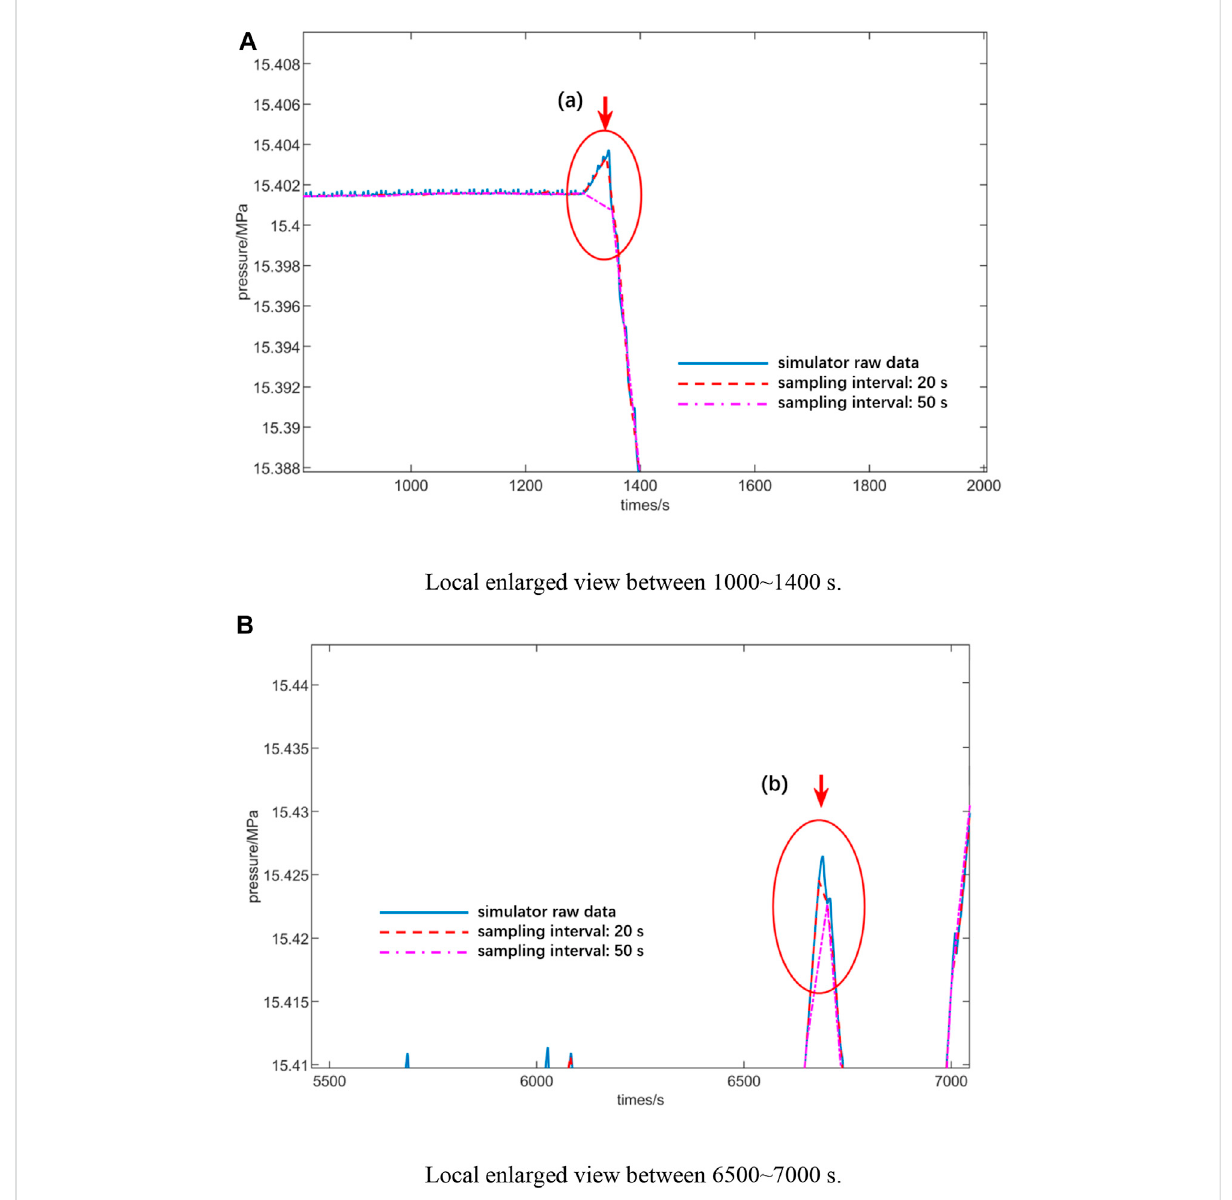
FIGURE 4 Local enlarged view of the two largest local differences between different sampling time intervals. (A) Local enlarged view between 1000 and 1400 s. (B) Local enlarged view between 6500 and 7000